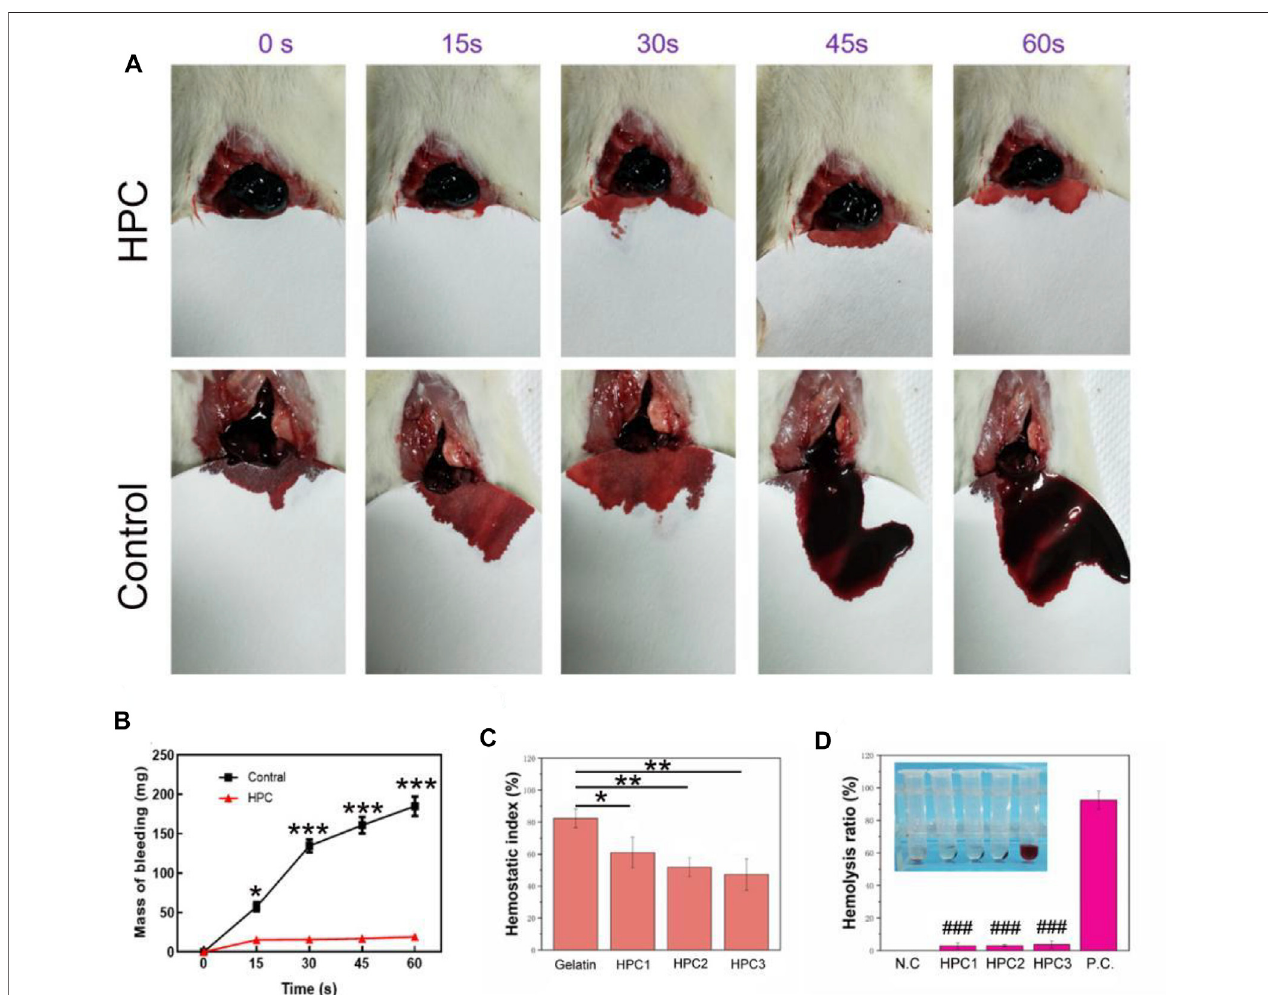
FIGURE 7 | Haemostatic performance of HPC hydrogels. (A) Haemostatic capability of the HPC-2 hydrogel. (B) Mass of bleeding with or without the treatment of HPC-2 hydrogel. (C) Haemostatic index of control and HPC samples. (D) Haemolysis ratio of HPC samples (** p < 0.05, ** p < 0.01, *** p < 0.001 ； ### p < 0.001vs P.C.